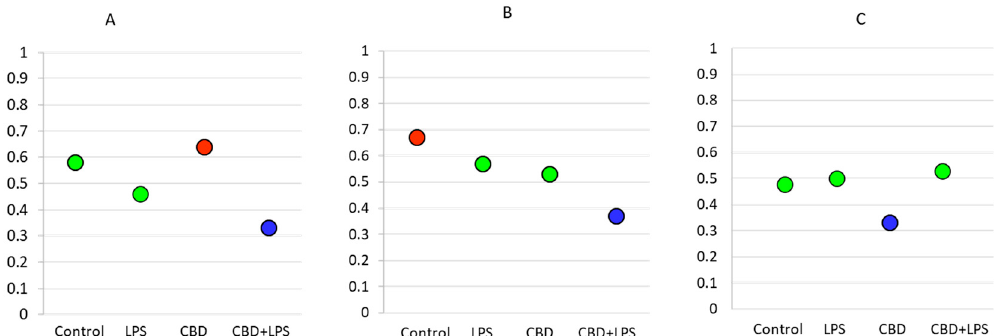
Figure 7. Spearman’s correlation index between PASI and relevant parameters. Blue circle—low correlation (Spearman correlation below 0.4); Green circle—medium correlation (Spearman correlation index from 0.4 to 0.6); Red circle—high correlation (Spearman correlation index from 0.6 to 0.8); ( A ) Percentage of NETotic cells and PASI; ( B ) MPO level and PASI; ( C ) cfDNA and PASI.